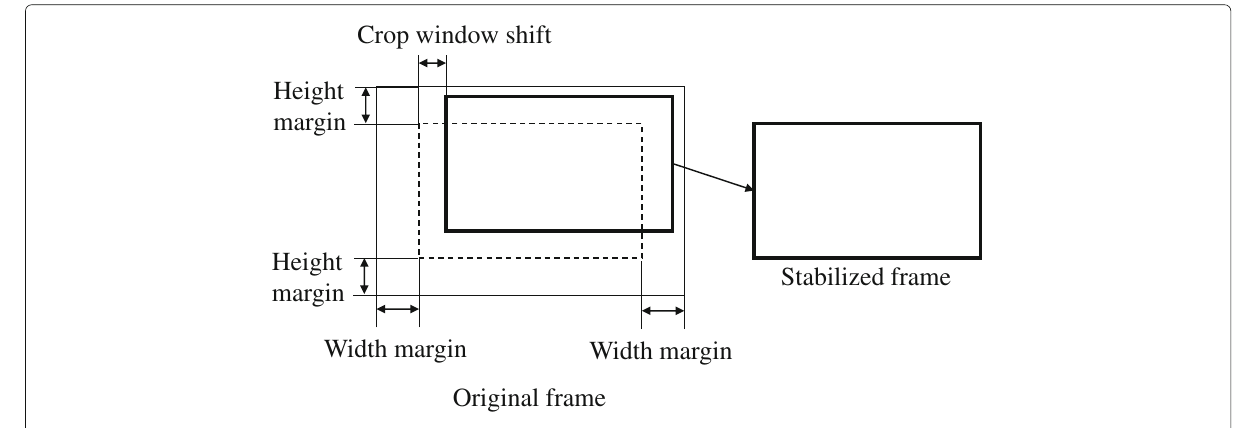
Fig. 1 Simple video stabilization with 2D translational motion